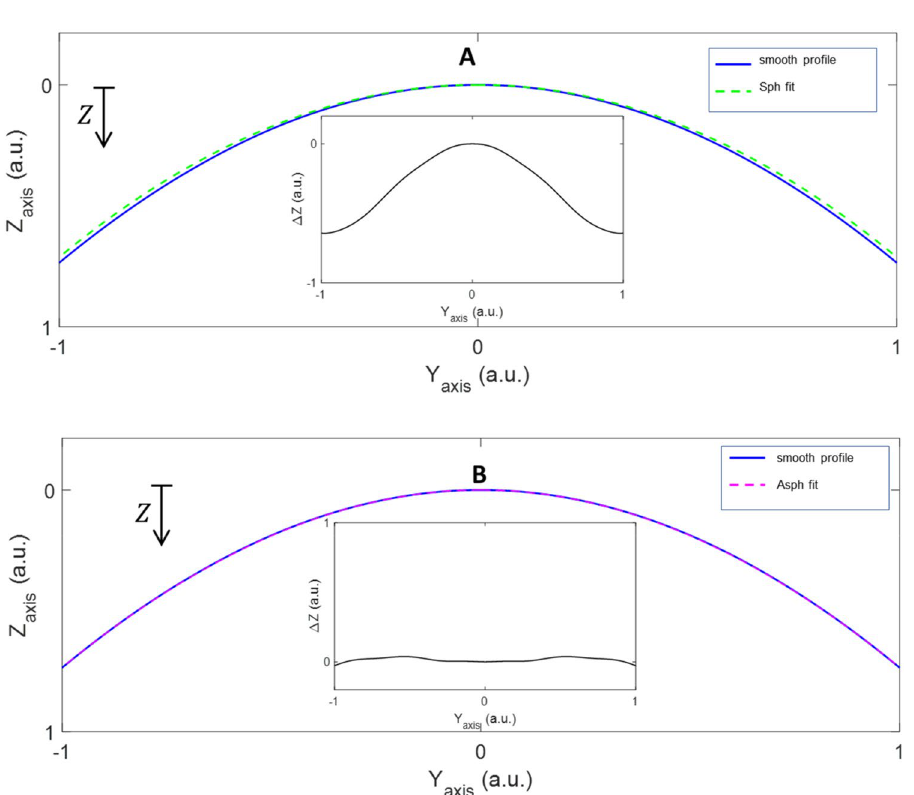
Figure 2. Example of a smoothed curve fitting to a sphere ( A ) or a sphere ( B ). Inserted in each figure is shown the differences of Δz regarding the reference